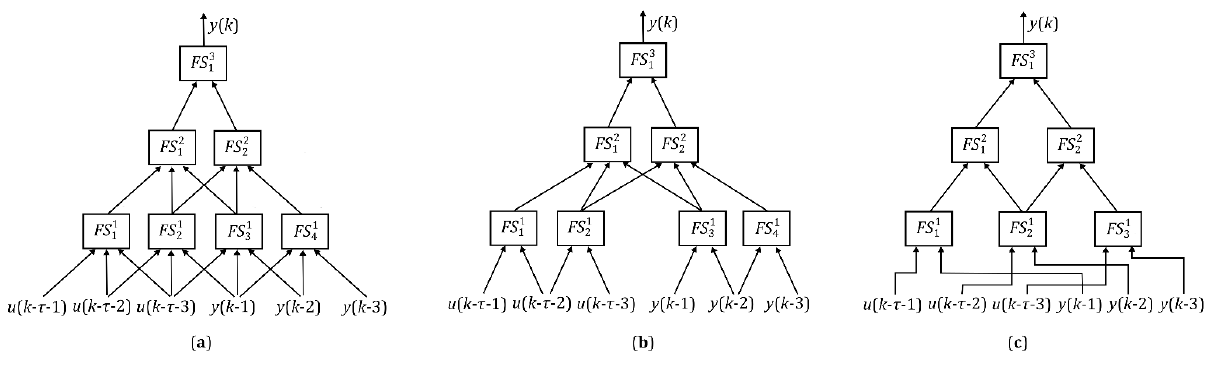
Figure 4. Different NARX DCFS structures are possible, and three are presented: ( a ) general structure of a NARX DCFS, ( b ) input–output NARX DCFS structure, and ( c ) sub-model NARX DCFS structure.